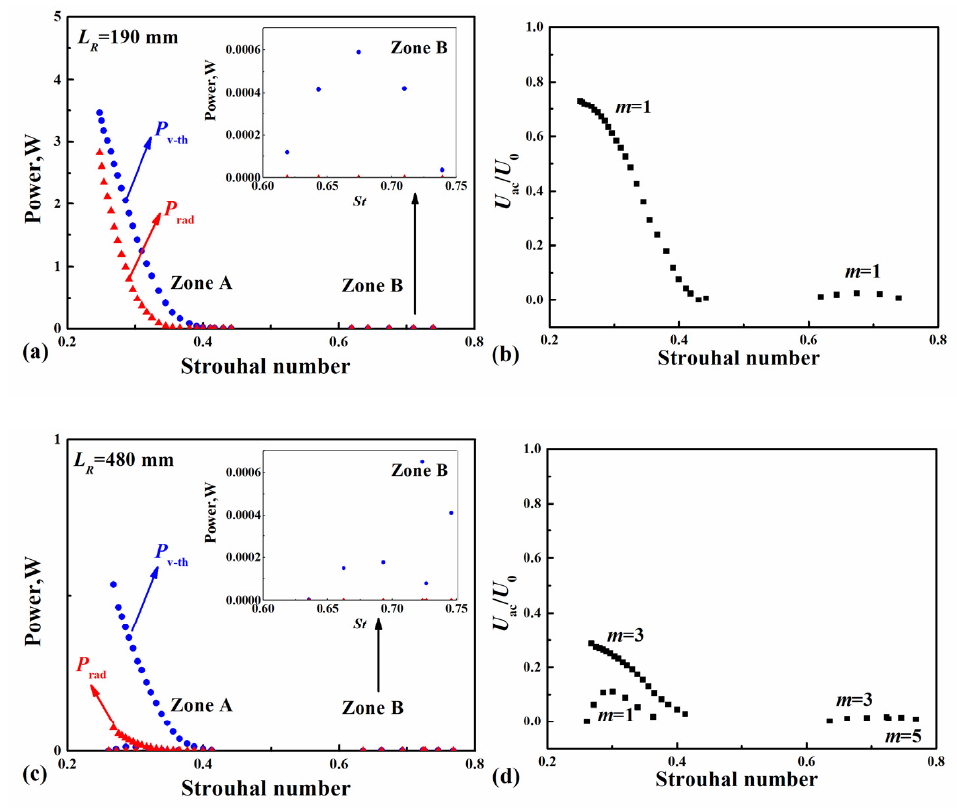
Figure 6. Variations in the visco-thermal acoustic loss P v-th , the radiation loss P rad , and the dimensionless acoustic pressure amplitude u a / U 0 versus the Strouhal number. ( a , b ) L R = 190 mm; ( c , d ) L R = 480 mm.